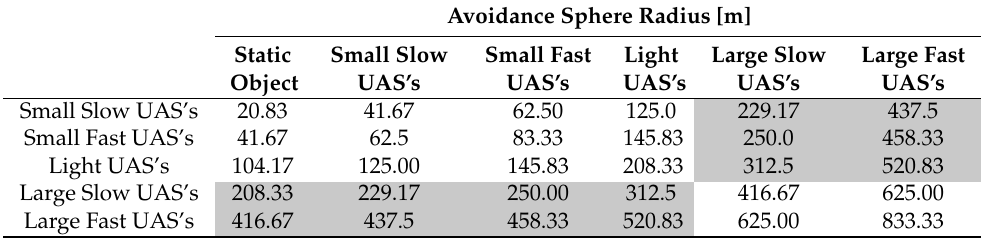
Table 2. Avoidance sphere radius for each categories